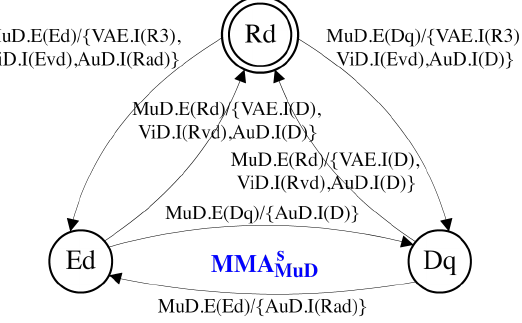
Figure 4. The self-mode mapping automaton of MuD.